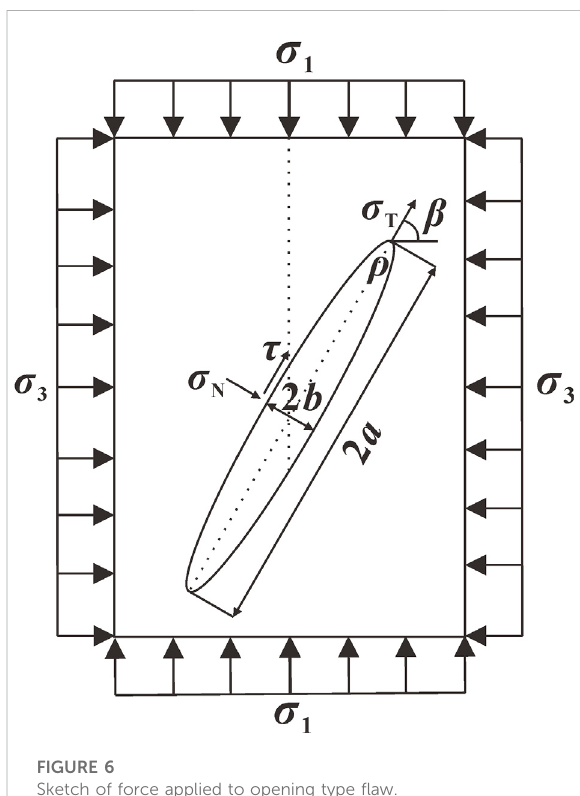
FIGURE 6 Sketch of force applied to opening type fl aw.